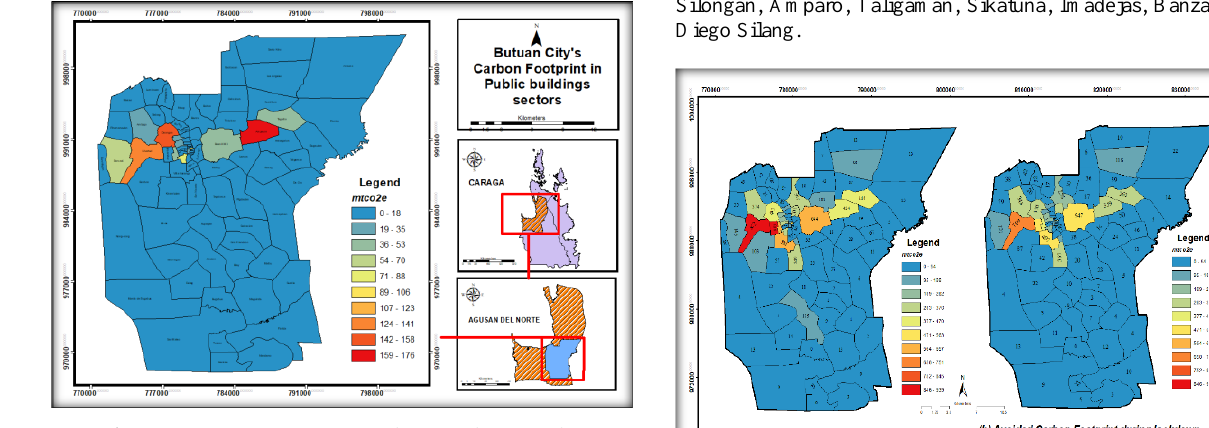
Figure 12. Spatial distribution of carbon footprint from